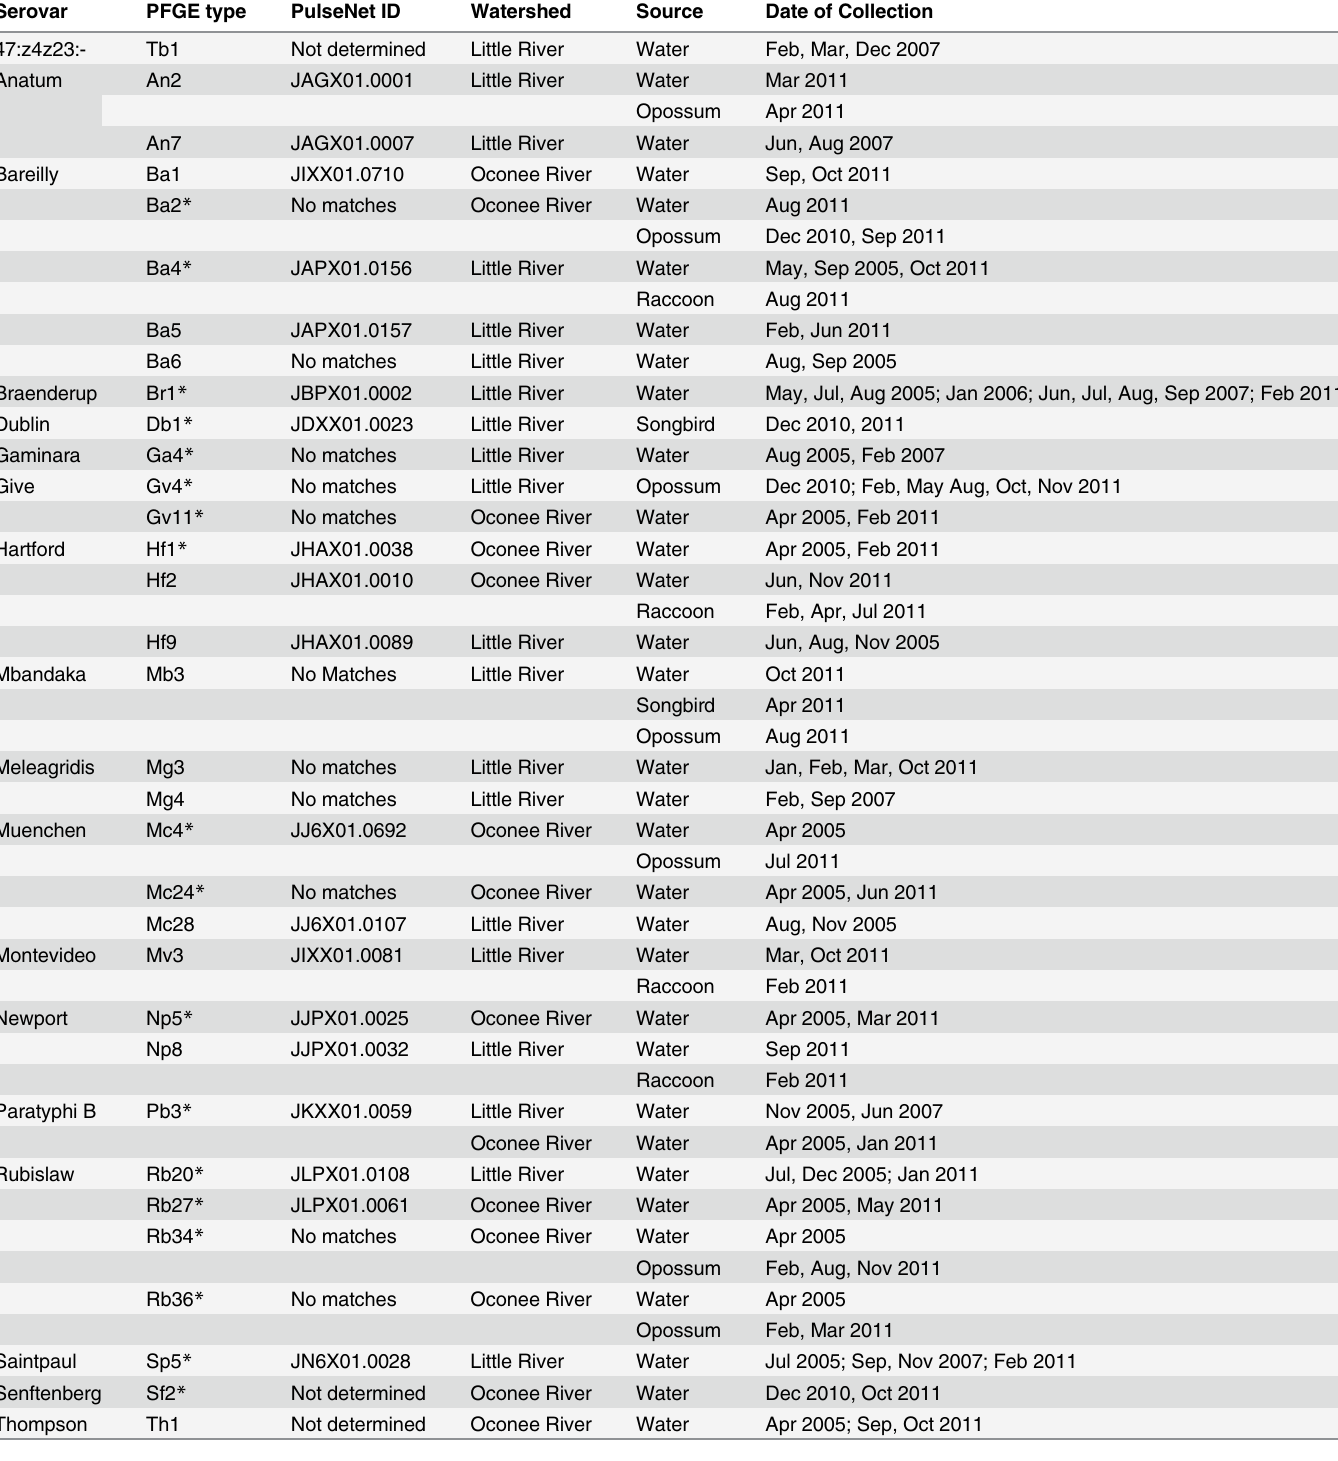
Table 3. Salmonella serovars and PFGE types isolated multiple times in the Little River or Oconee River watersheds (both water and animal sources) between 2005 and 2011.